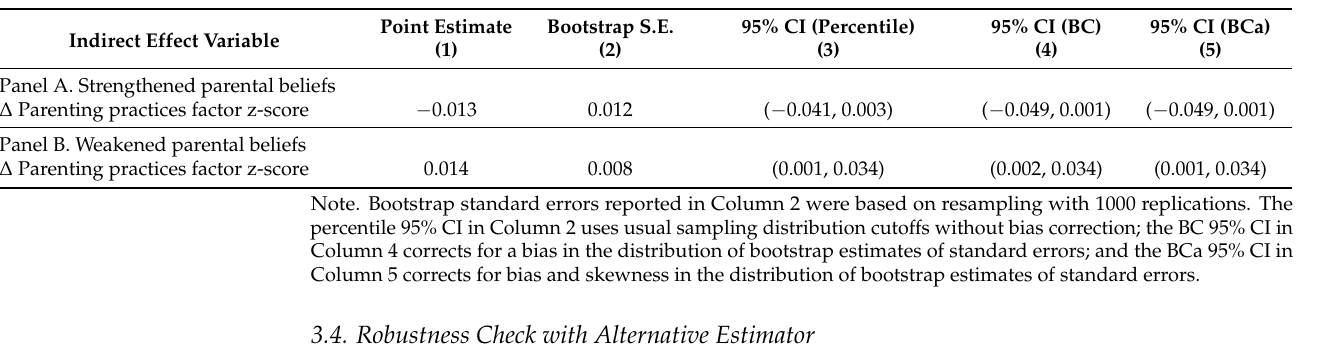
Table 7. Estimates of indirect effect of strengthened and weakened parental beliefs on child social– emotional development through parenting practices (Wave 1 to Wave